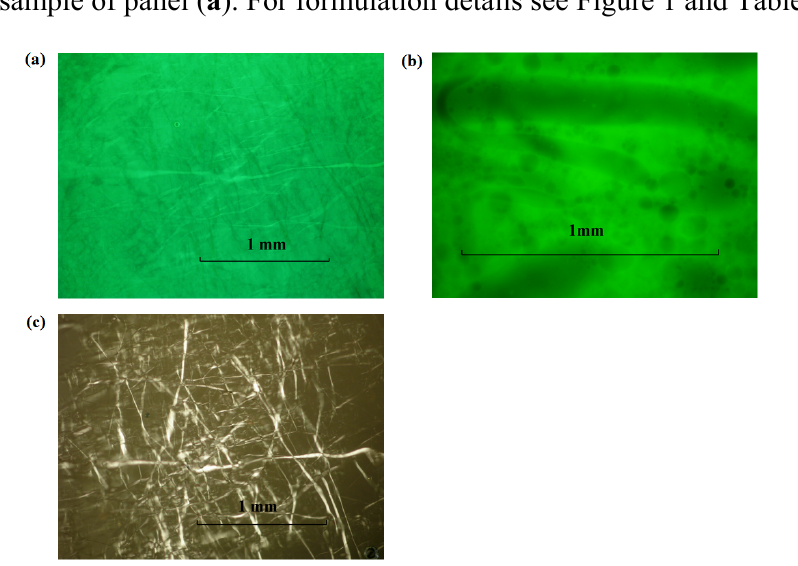
Figure 4. Fluorescence image of lecithin-linker 2% SMO MBG (20% gelatin) at room temperature labeled with ( a ) sodium fluorescein and ( b ) nile red; ( c ) Cross-polarized light image of the sample of panel ( a ). For formulation details see Figure 1 and Table 1.